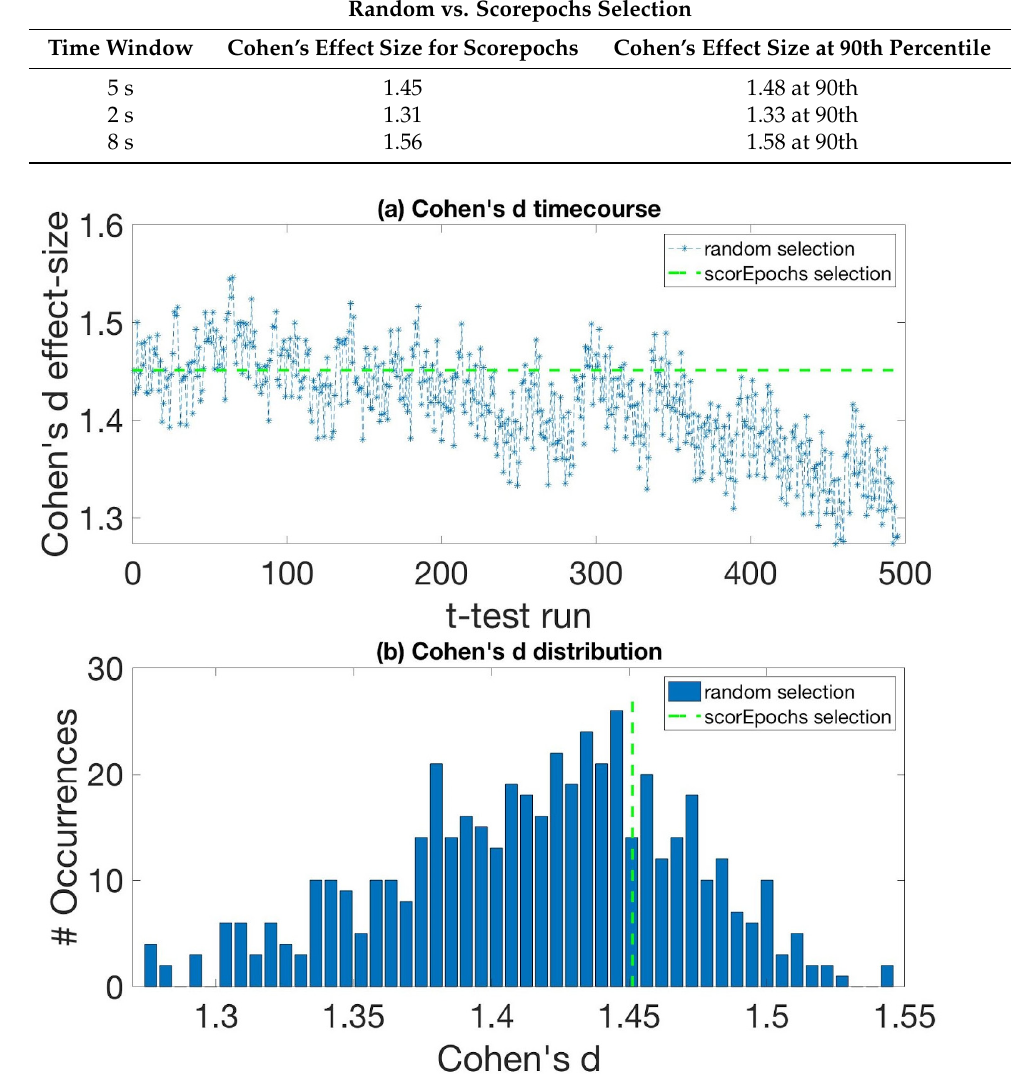
Figure 2. Cohen’s d effect sizes for random selection and Scorepoch selection using a time window equal to 5 s. ( a ) The ‘time course’ of the effect size computed using a sequential random selection. The effect size values are reported in the y-axis, while the x-axis indicates the t -test with sequential random selection. The green dashed line represents Cohen’s d value obtained by selecting the epochs using Scorepochs. ( b ) Cohen’s d effect size distribution for the random epoch selection and the Scorepochs selection. The effect size values are reported on the x-axis, while the y-axis indicates the occurrences of specific effect size values. The vertical green dashed line represents Cohen’s d value from selecting the 4 epochs suggested by Scorepochs.